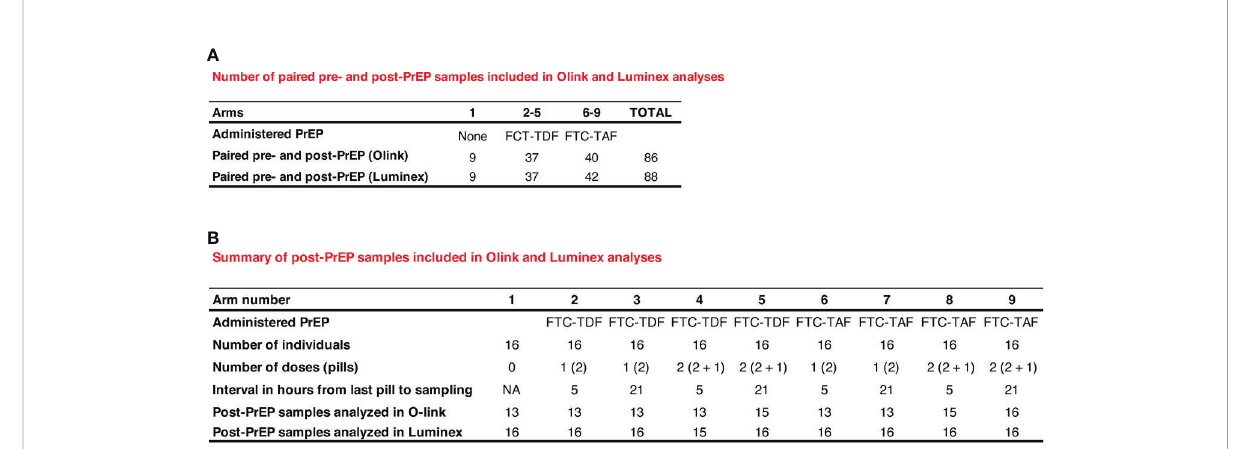
FIGURE 1 Description and numbers of clinical samples used in Olink and Luminex assays. In (A) paired pre- and post-PrEP samples are shown. In (B) the number of samples obtained post-PrEP from individuals included in the different PrEP arms are